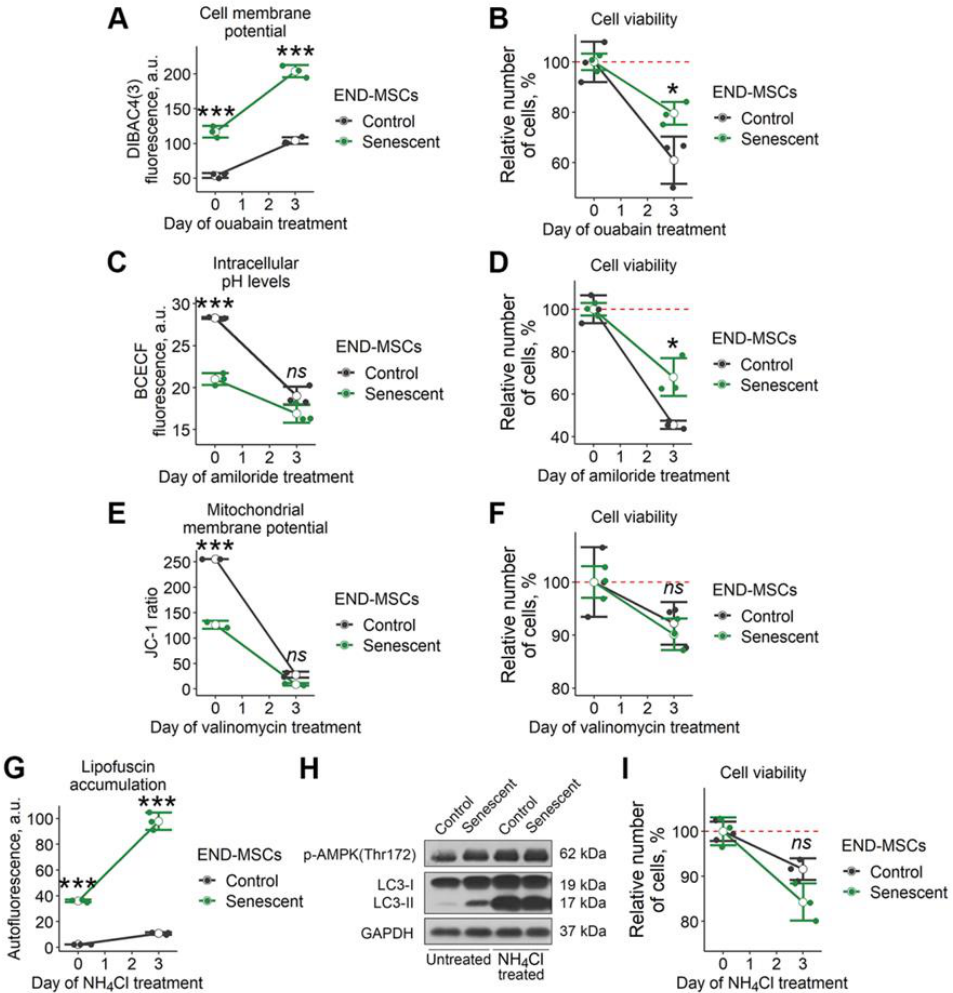
Figure 3. Senescent END-MSCs retain viability during modulation of separate cell homeostasis parameters. Senescent and control END-MSCs were treated with substances that modulate separate cell physiological parameters and were measured for viability after 3 days of exposure. ( A , B ) Cell membrane potential changes and viability under 1 μM ouabain treatment. ( C , D ) Intracellular pH levels and viability during 1 mM amiloride treatment. ( E , F ) Mitochondrial membrane polarization and viability during 100 μM valinomycin treatment. ( G – I ) lipofuscin accumulation, autophagy activity indicators and viability during 1 μM NH 4 Cl treatment. Cell viability data presented as relative cell viability (%) of control and senescent END-MSCs 3 days after treatment with each substance. Values presented are mean ± s.d. For comparison of parameters and viability of control and senescent cells with treatment, two-way ANOVA with Tukey's HSD was applied, n = 3, ns — not significant, * p < 0.05, *** p < 0.005. Full-length blots are presented at Supplementary Figure S1C; GAPDH was used as loading control.